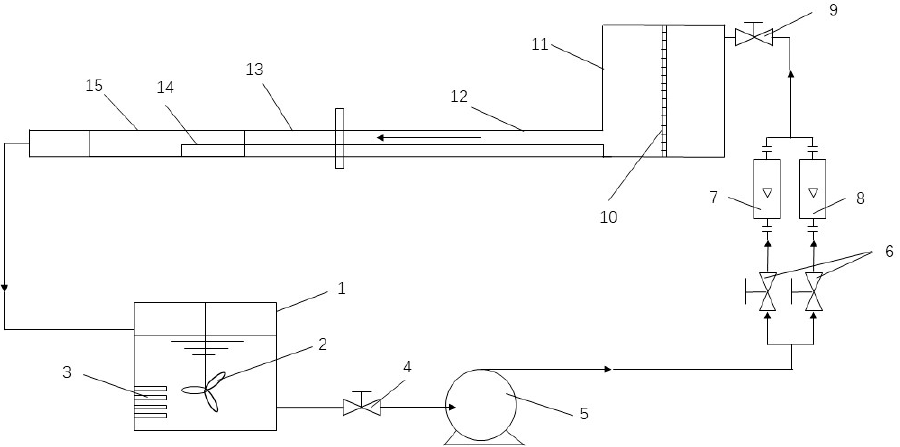
Figure 2. Schematic diagram of experimental system. 1: Reclaimer; 2: mixer; 3: constant temperature heater; 4,6,9: valve; 5: water pump; 7: large flow rotor flowmeter; 8: small flow rotor flowmeter; 10: overflow plate; 11: intake tank; 12: development section; 13: test section; 14: step; 15: quartz glass window .